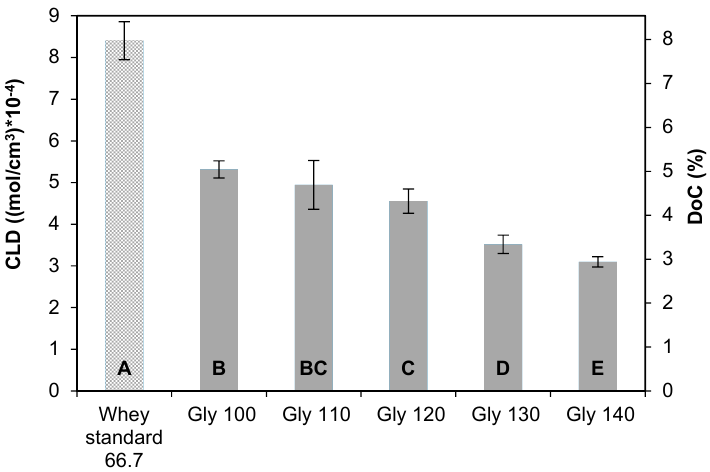
Figure 2. Cross-linking density (CLD) and the degree of cross-linking (DoC) of whey protein isolate (WPI)-based cast film (standard) and potato protein isolate (PPI)-based cast films as a function of glycerol (Gly) concentration ( w / w protein). Columns with different letters are significantly different ( p < 0.05). Error bars denote standard deviation.